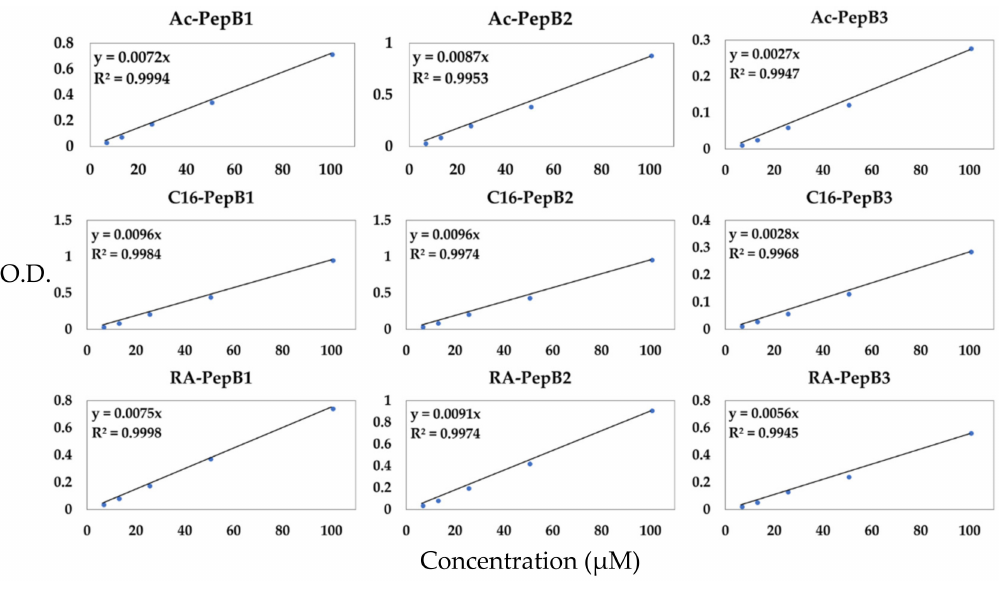
Figure 4. Standard curves to determine filtered peptide concentrations in cytotoxicity and differentiation experiments. N = 9 per standard. O.D.: optical